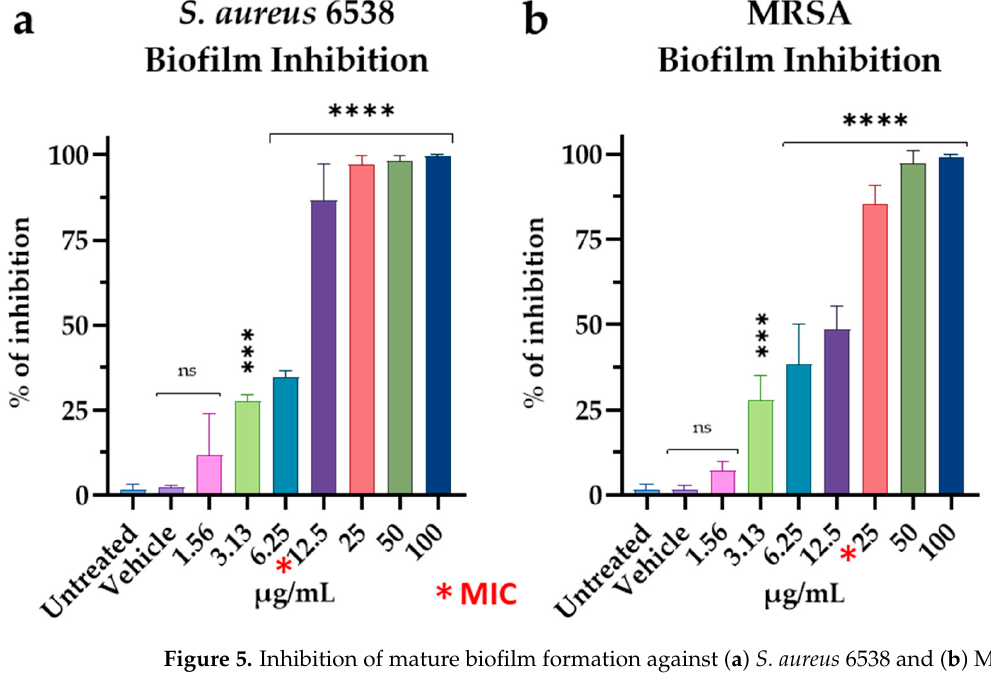
Figure 5. Inhibition of mature biofilm formation against ( a ) S. aureus 6538 and ( b ) MRSA. Statistical analyses were determined by ANOVA with Dunnett’s test for multiple comparisons. Significances are referred to the untreated bacteria. **** p < 0.0001, *** p < 0.0002, ns (not statistically significant).